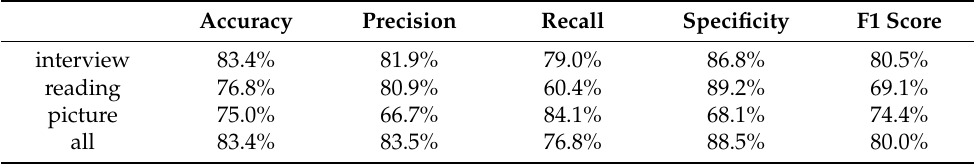
Table 3. Performance indicators of different database decision tree